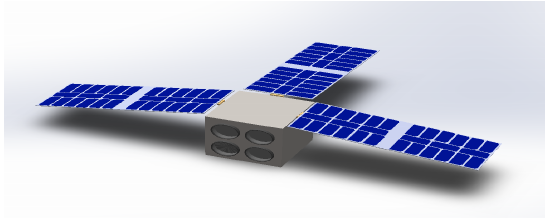
Figure 3. Satellite